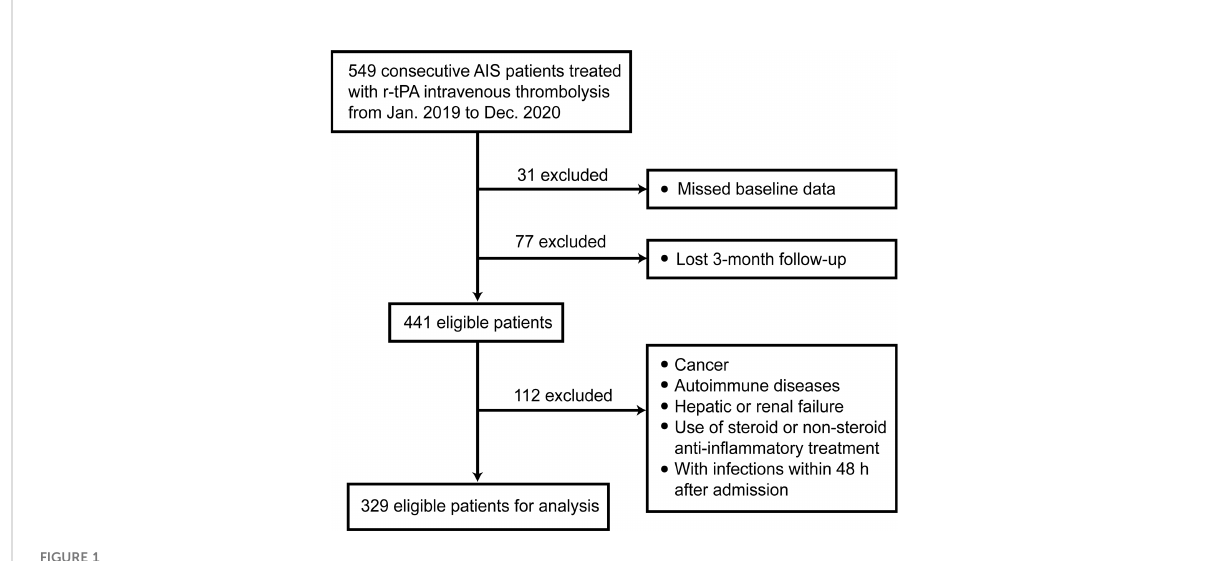
FIGURE 1 Flow chart for patient